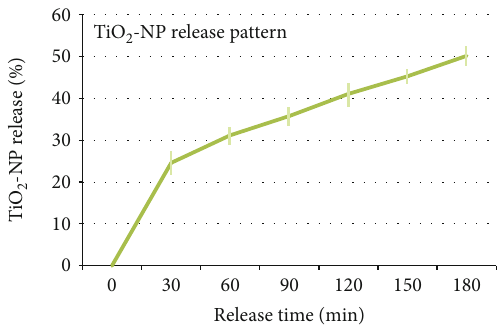
Figure 4: The release pattern of TiO nanocomposite with nanochitosan. ∗ Values are mean of triplicates with the illustrated error bars.